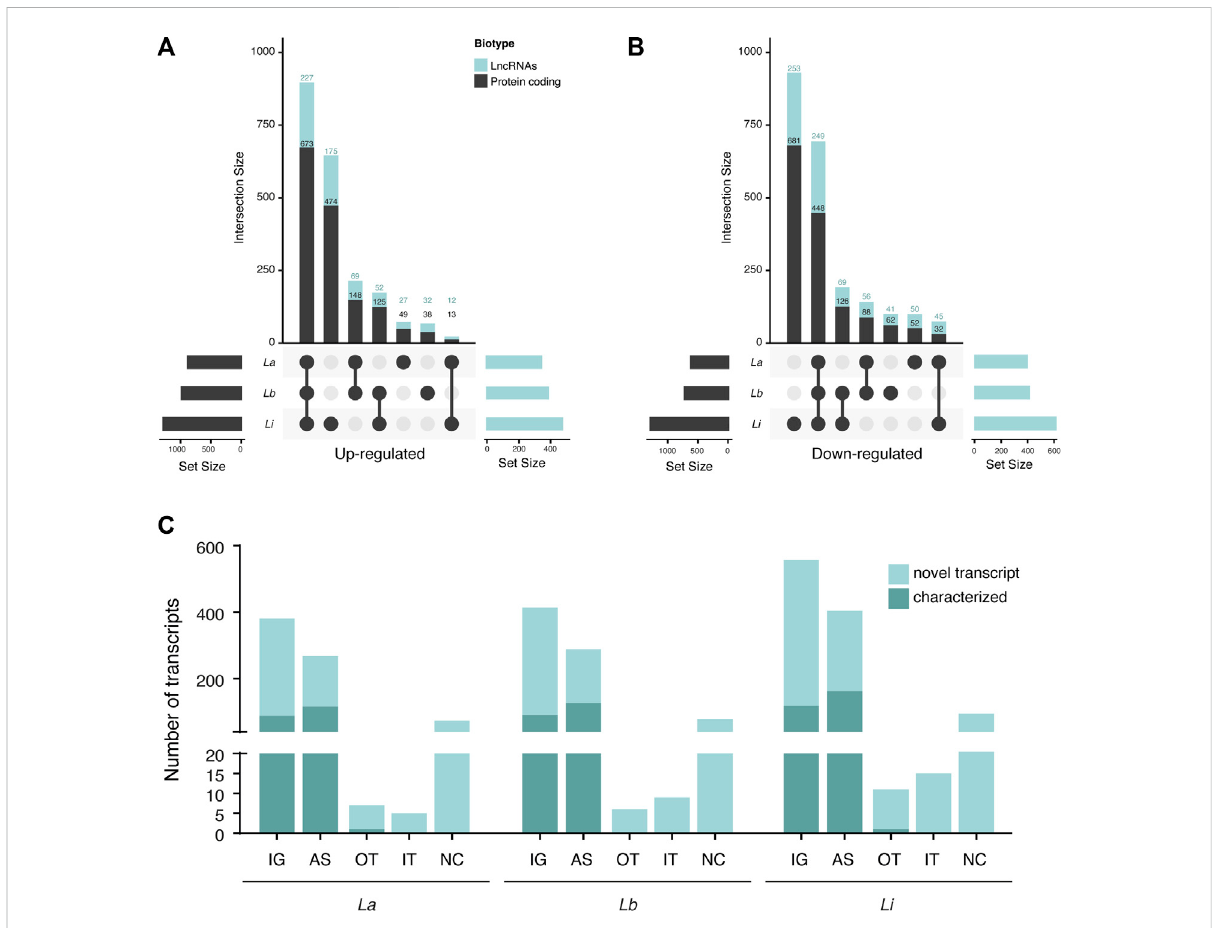
FIGURE 1 Number of differentially expressed protein coding and long noncoding RNAs subtypes in Leishmania -infected THP-1 macrophages. (A) Intersection plot representing the number of signi fi cantly upregulated lncRNAs and protein coding genes from La -, Lb - and Li -infected THP-1 macrophages( N = 5); (B) Intersection plot representing the number of signi fi cantly downregulated lncRNAs and protein coding genes from La -, Lb - and Li -infected THP-1 macrophages ( N = 5); (C) Number of transcripts of each lncRNA type classi fi ed using the GRCh38.p13 database. The transcripts from the GRCh38.p13 database that lack validation studies are referred to as novel transcripts. IG: intergenic, AS: antisense; OT: overlapping transcript; IT: intronic transcript; NC: non-classi fi